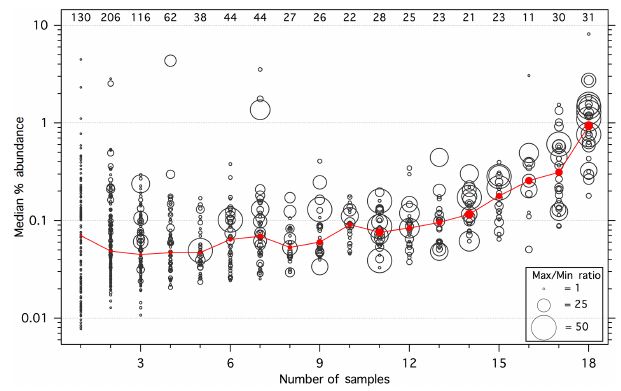
Figure 3. The black circles represent the median percentage (ig- noring zeros) of the total SPE peak area for each observed com- pound as a function of the number of SPE samples that contained that compound; for compounds observed in only one or two sam- ples, the maximum percent abundance was used in place of the median. Marker size is proportional to the range of percent abun- dances observed for each compound (capped at 50), calculated as the ratio of the maximum value to the minimum non-zero value. The red trace represents the median of the values shown for each num- ber of samples, with the marker sizes corresponding to the median max / min ratio. The numbers along the top represent the number of compounds observed within each